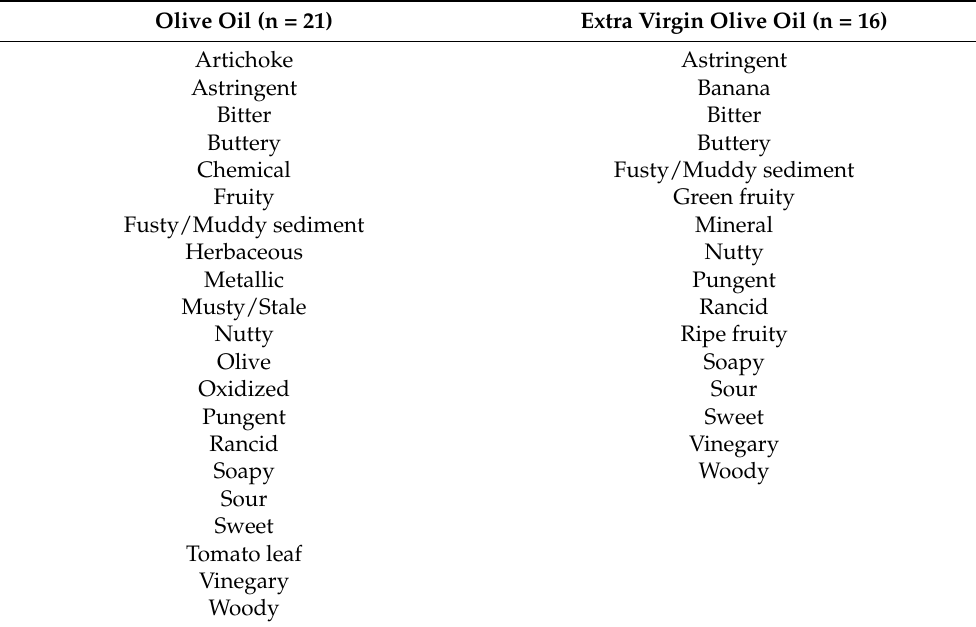
Table 1. Attributes used for the CATA test for olive oil (OO) and extra virgin olive oil (EVOO). Olive Oil (n = 21) Extra Virgin Olive Oil (n =